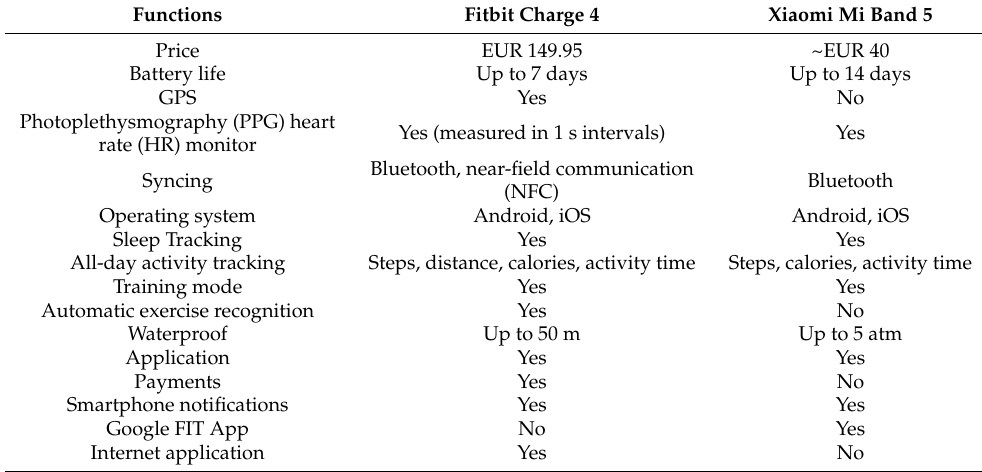
Table 1. Features and specifications of the Fitbit Charge 4 and Xiaomi MI Band